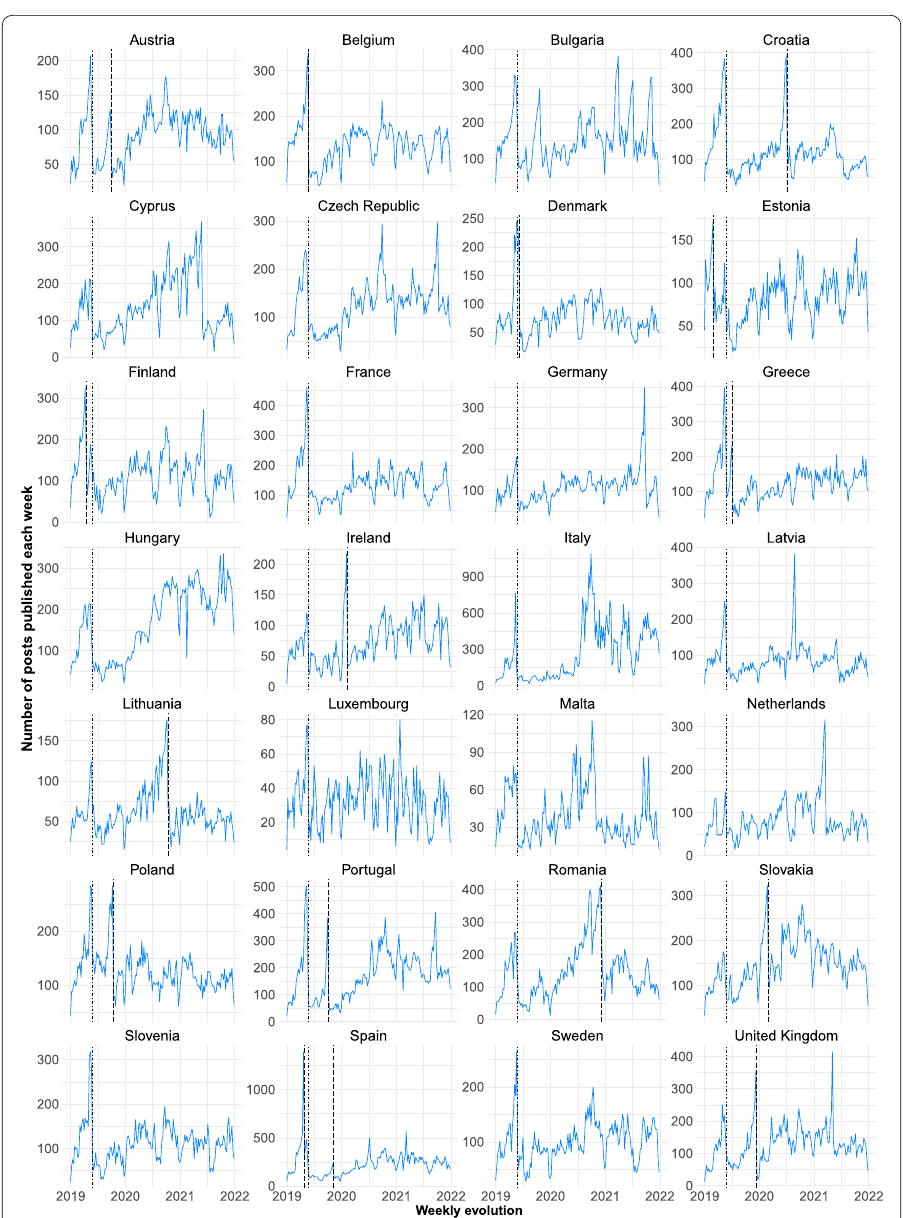
Figure 15 Posts published by country with elections. Each vertical line represents an